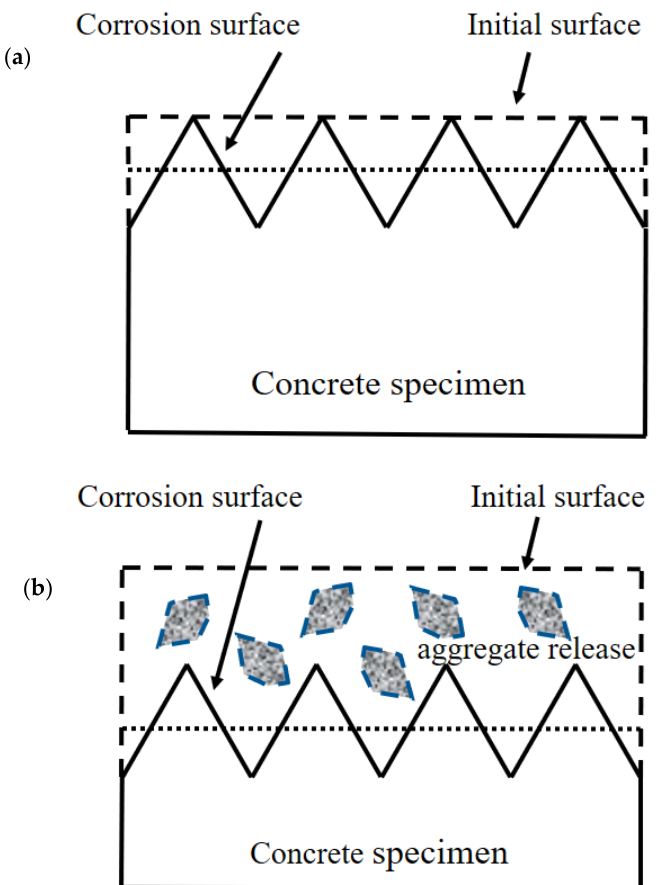
Figure 16. Analysis of the reasons of the roughness changes of the surface at different stages. ( a ) At the early erosion stages, ( b ) At the later erosion stages.